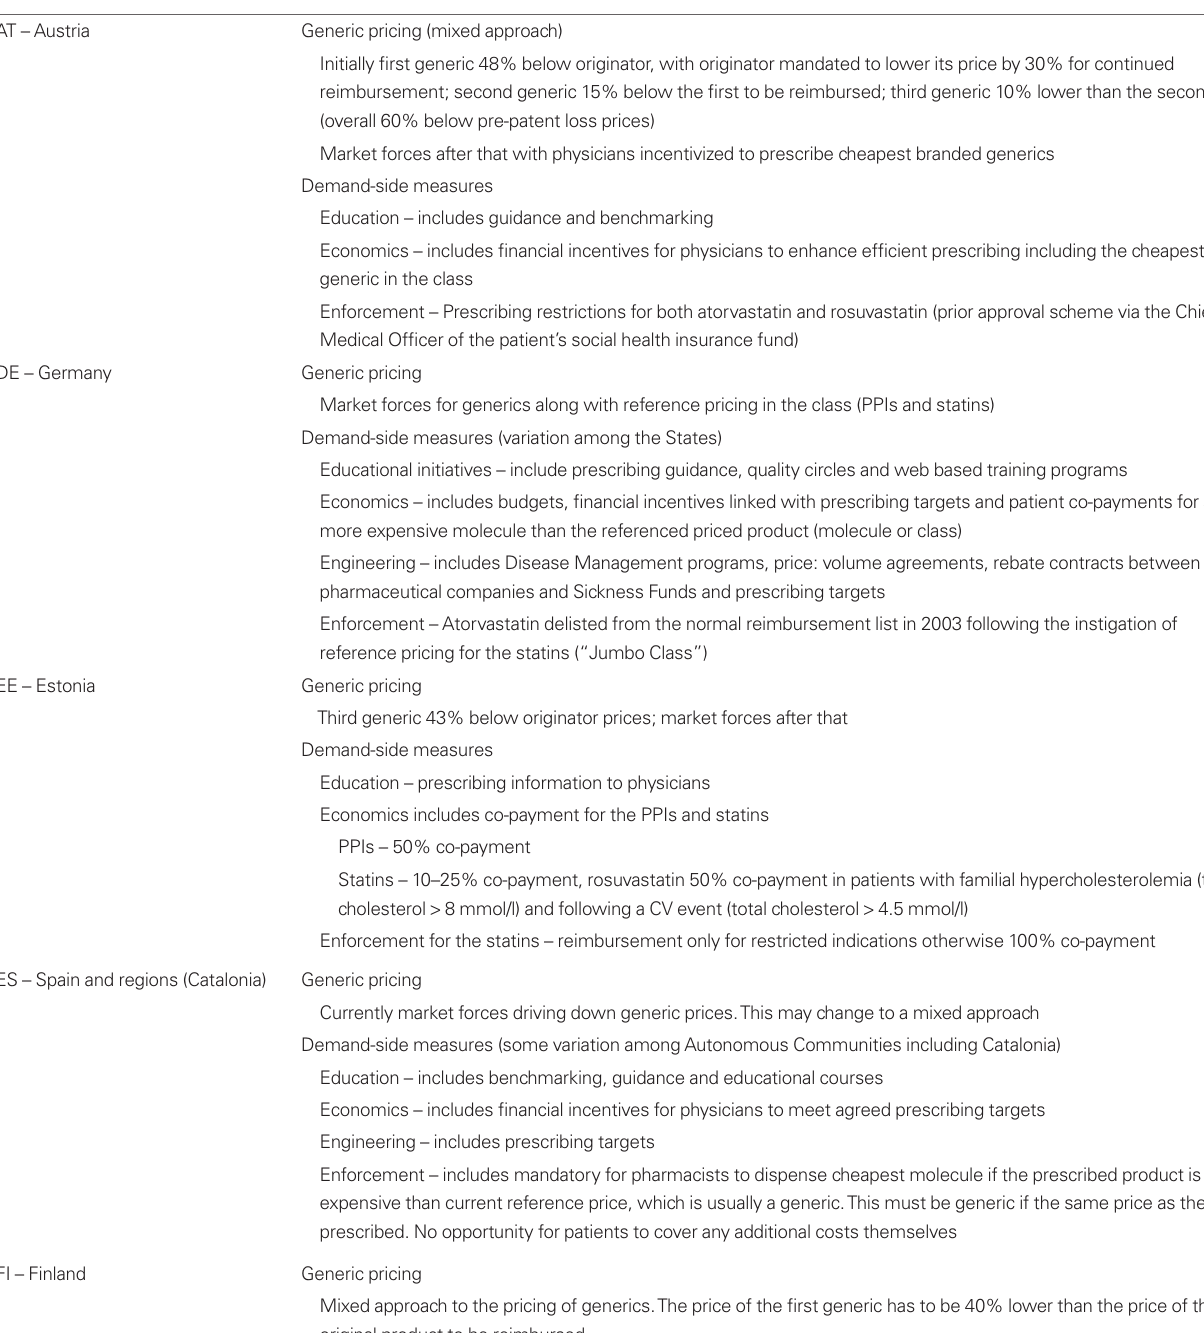
Table A1 | Pricing approaches for generics and major demand-side measures principally for the PPIs and statins among the different European countries typically up to 2007 (Von Ferber et al., 1999; Schmacke and Lauterberg, 2002; Wessling and Lundin, 2006; Hyde, 2007; Magrini et al., 2007; Office of Fair Trading, 2007; Peura et al., 2007; Sakshaug et al., 2007; Fattore and Jommi, 2008; Festoy et al., 2008; Godman et al., 2008a,b, 2009b,c, 2010a,b,c; Simoens, 2008a; Teixeira and Vieira, 2008; Wettermark et al., 2008, 2009a,b, 2010a; Eriksson and Lundin, 2009; Adamski et al., 2010; Barry et al., 2010; DoH, 2010; Martikainen et al., 2010; McGinn et al., 2010; Sermet et al., 2010; Stock et al., 2010)